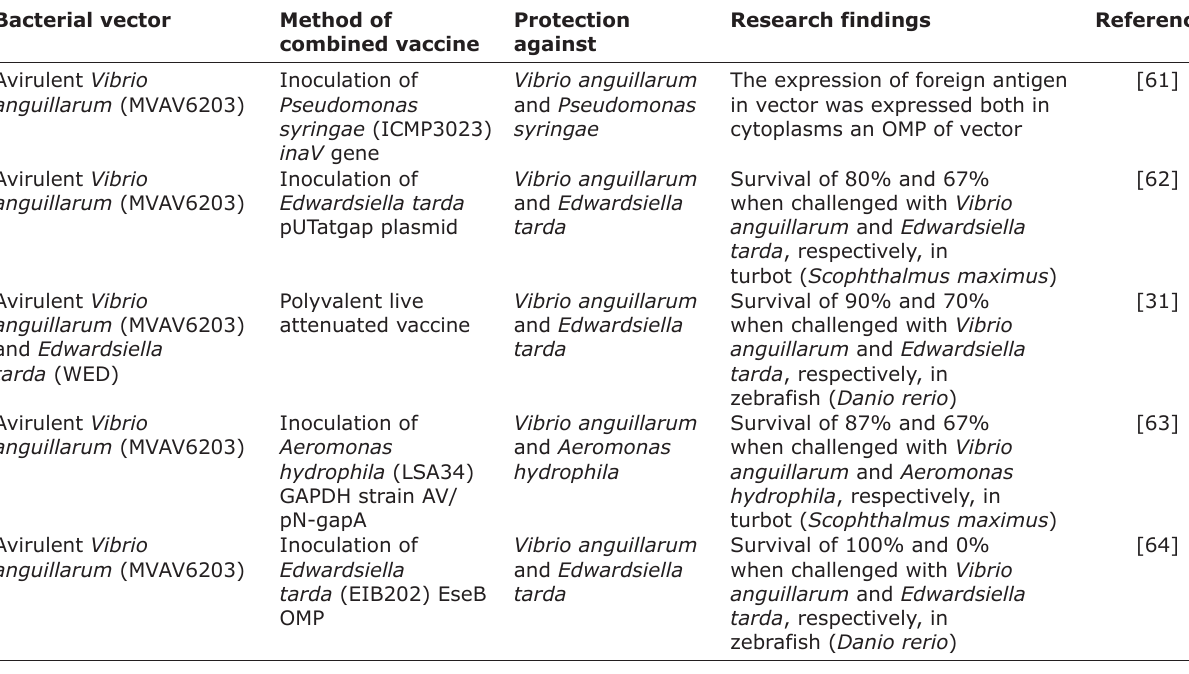
Table-2: Combined live-attenuated vaccine of Vibrio spp. Bacterial